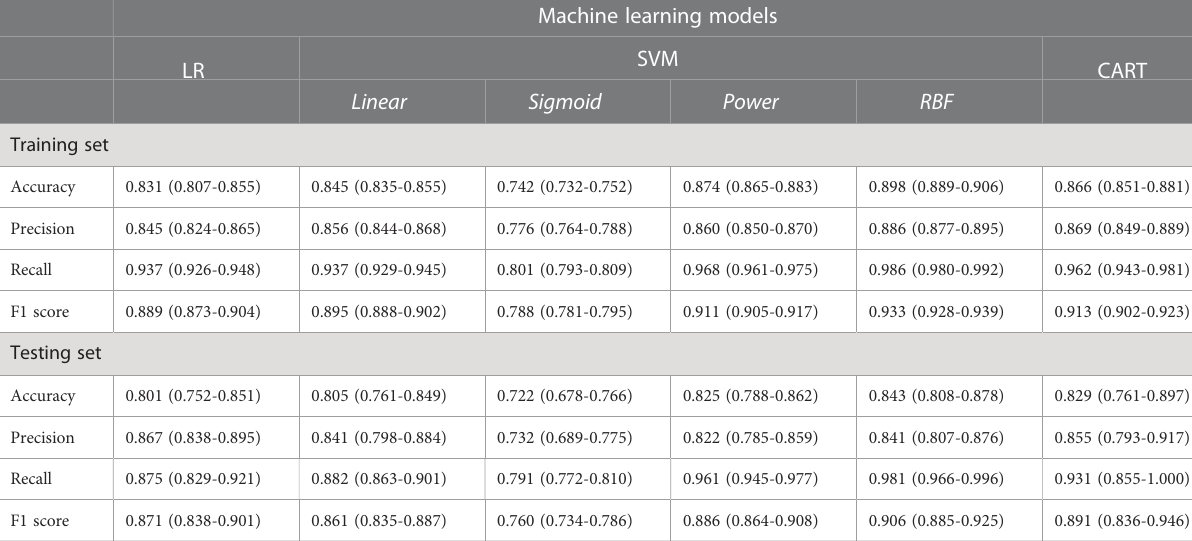
TABLE 3 Performances of the LR, SVM and CART classi fi er for the training and validation datasets.